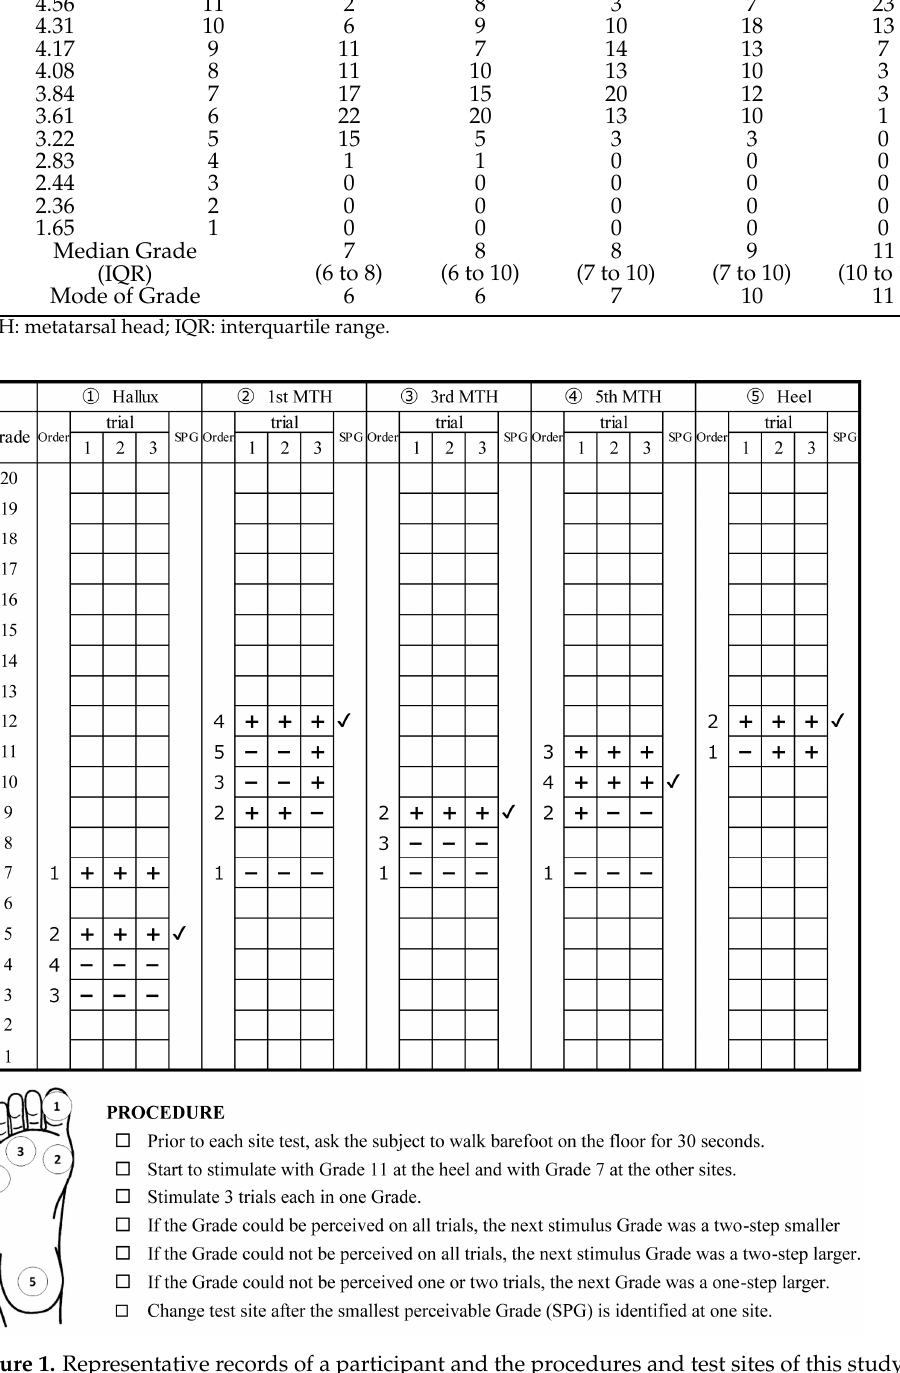
Figure 1. Representative records of a participant and the procedures and test sites of this study.